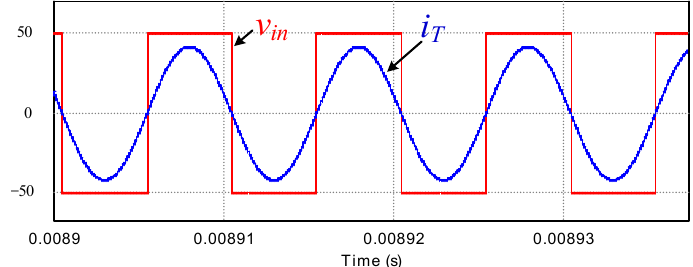
Figure 10. Voltage and current simulation waveform of full-bridge inverter.